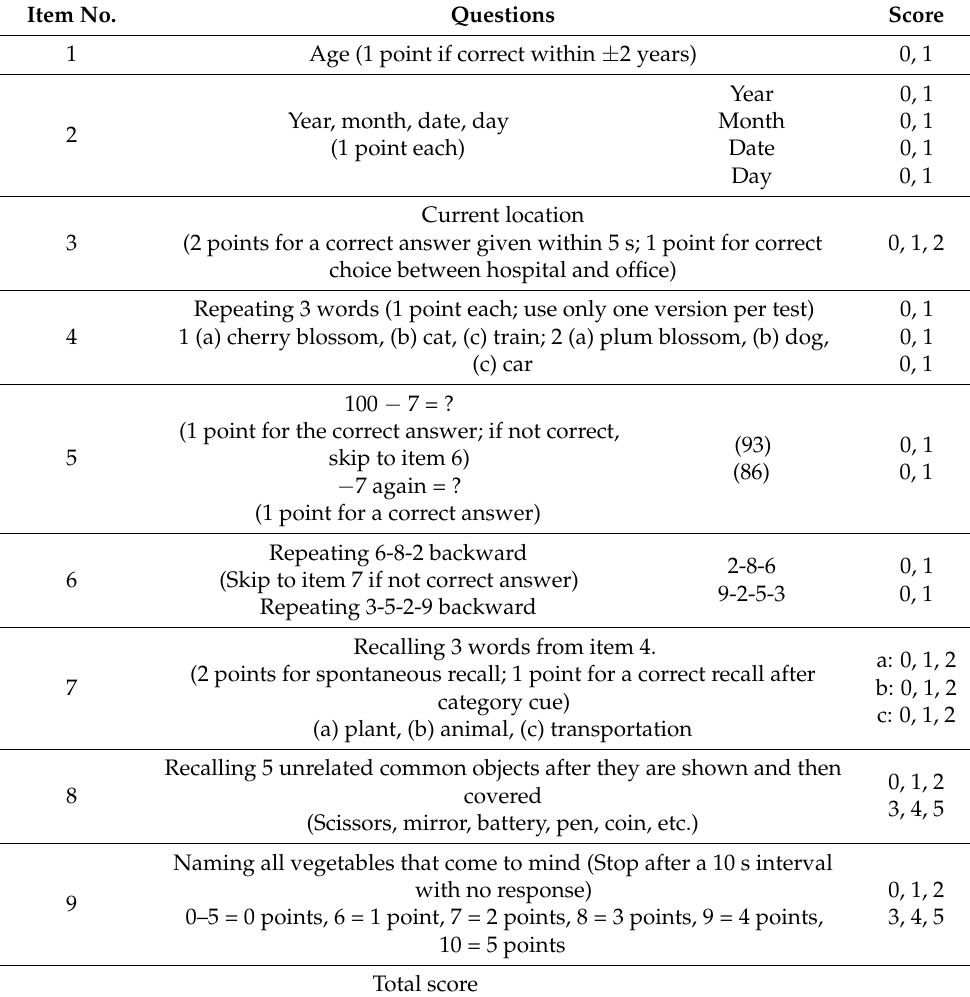
Table 1. The revised Hasegawa’s dementia